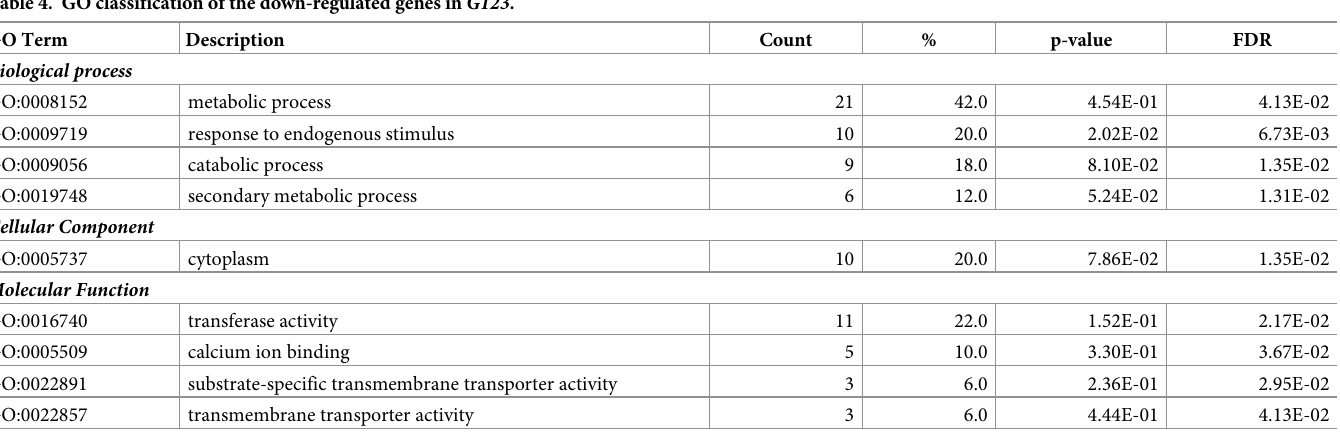
Table 4. GO classification of the down-regulated genes in G123 .